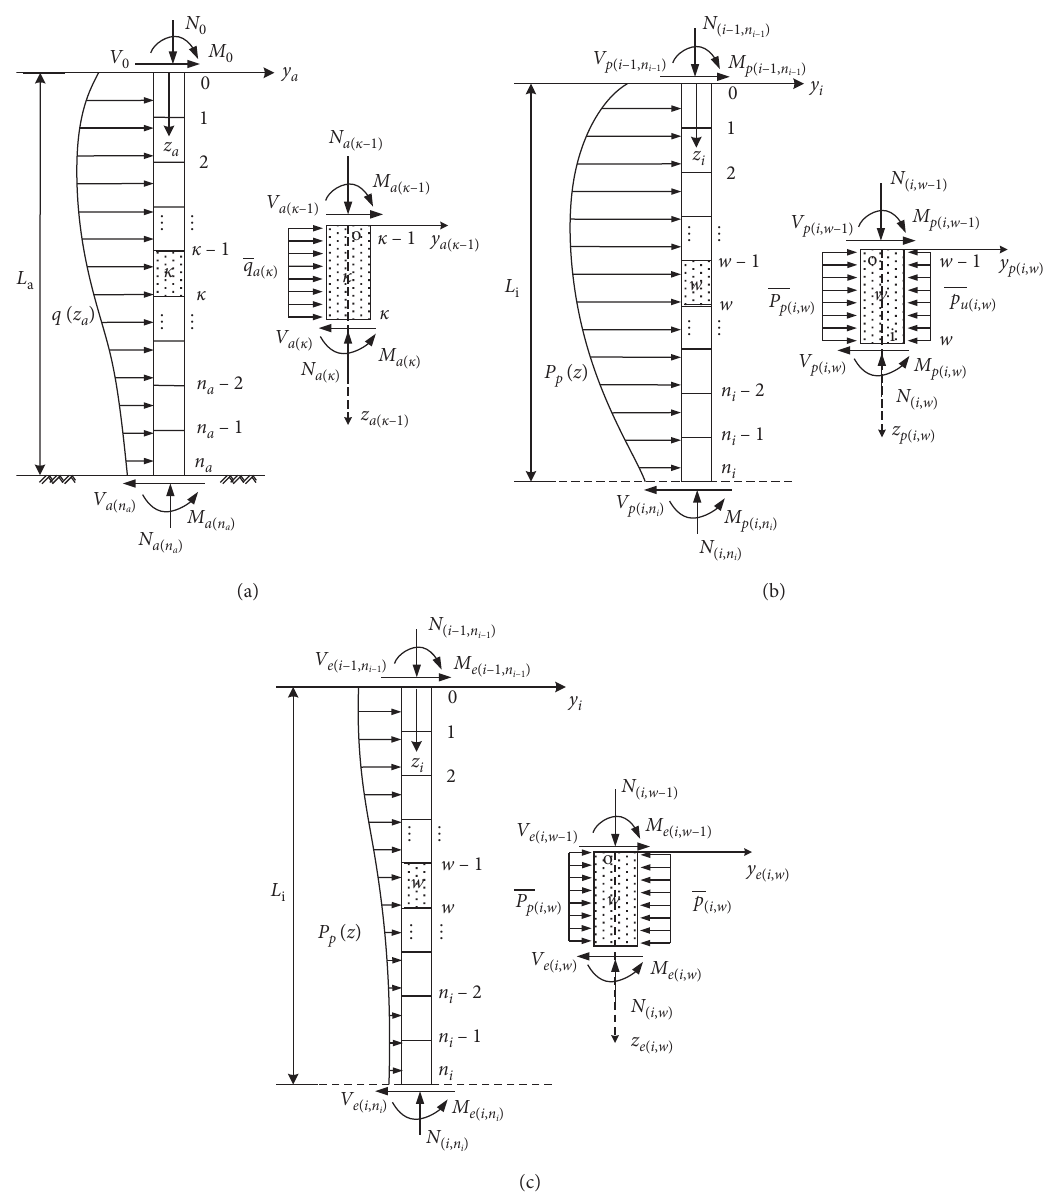
Figure 3: Pile discretization. (a) Free zone. (b) Soil in plastic state. (c) Soil in elastic